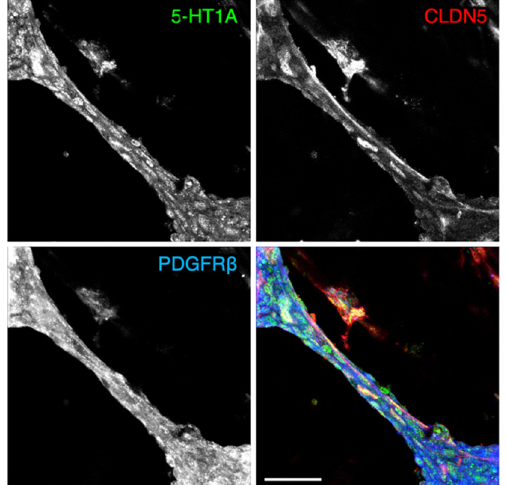
Figure 5. Expression of the 5-HT1A receptor in the human brain microvascular endothelial cell– pericyte tube-like structure in vitro. Confocal images of two-dimensional co-culture stained for HT1A, CLDN5, and PDGFR β . Scale bar, 50 µm.